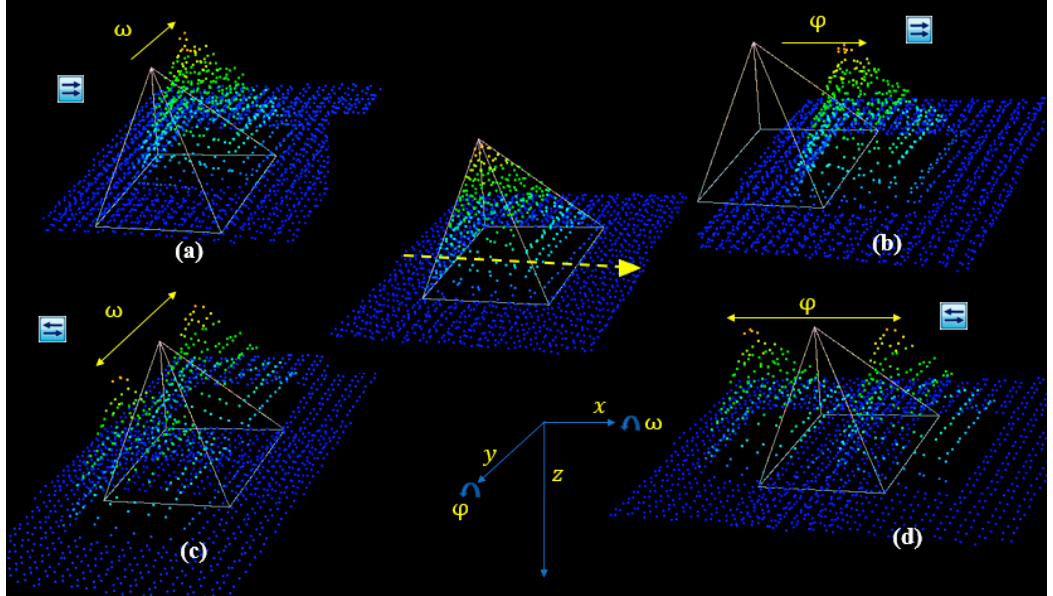
Figure 8. The e ff ect of boresighting angle error: ( a ) Overestimated ω for parallel same direction, ( b ) overestimated ϕ for parallel same direction, ( c ) overestimated ω for parallel opposite direction, ( d ) overestimated ϕ for parallel opposite